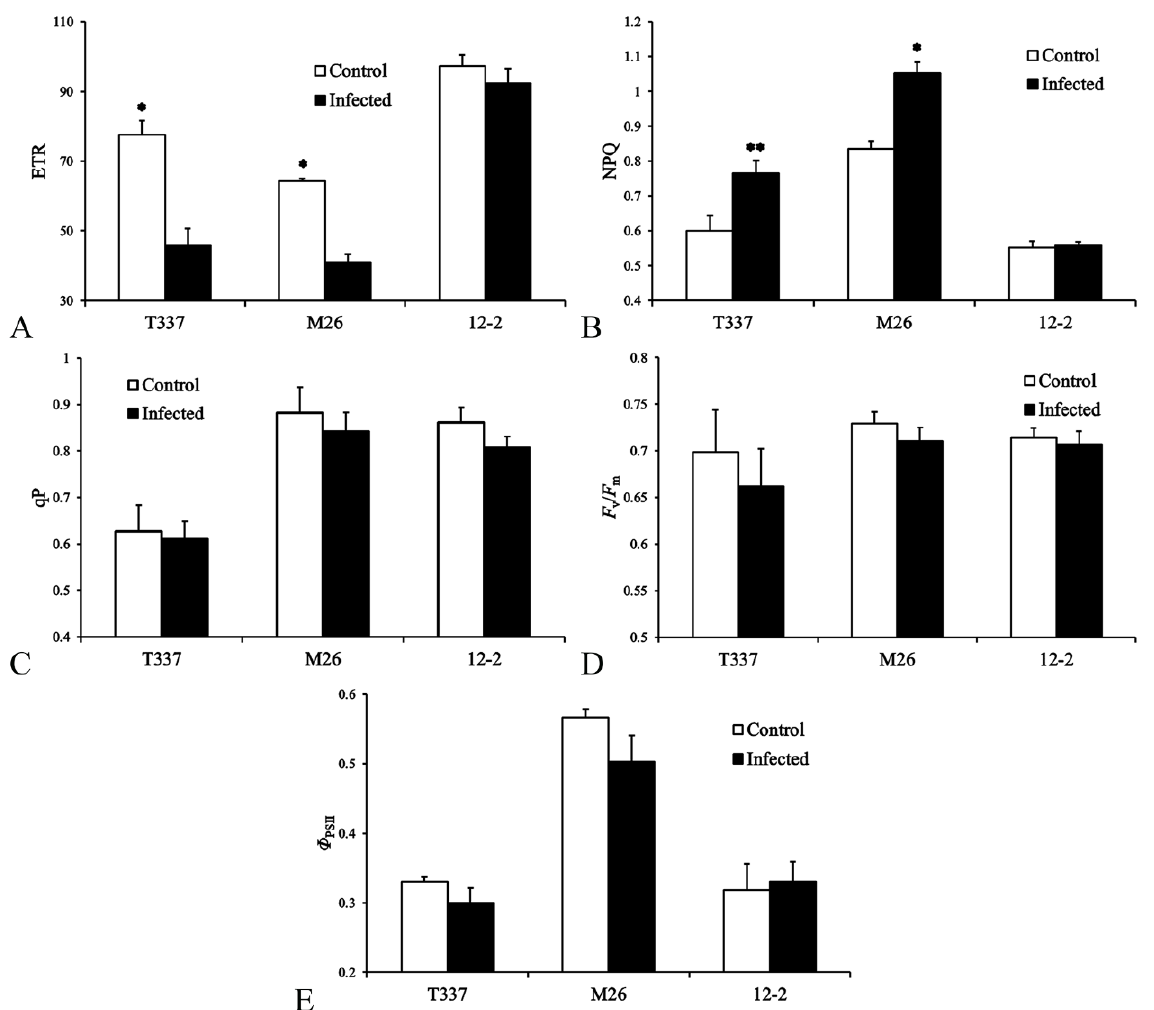
Figure 4. Effects of F. proliferatum MR5 on leaf fluorescence parameters: ( A ) ETR; ( B ) NPQ; ( C ) qP; ( D ) F v / F m ; ( E ) Φ PSII . The Student’s t -test was used to detect differences between the control and infected treatments within a rootstock. * p < 0.05; ** p < 0.01.